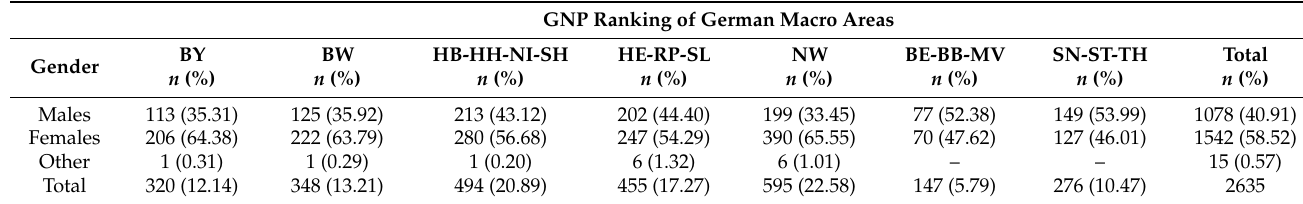
Table 1. Responders’ distribution among gender and German macro areas. As the number of respondents (gender = other) was practically nil, only males and females were considered for the statistical analysis.